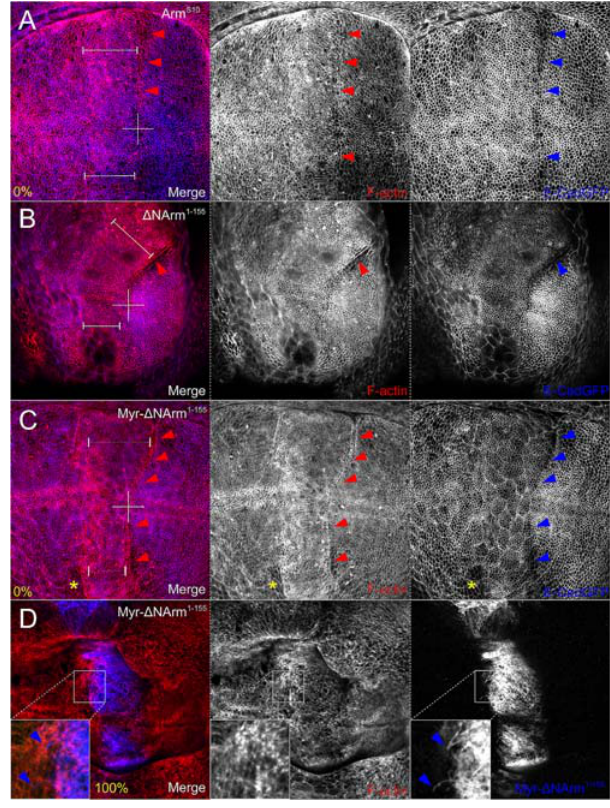
Figure 14. Phalloidin staining reveals a strong F-actin cable at the A/P boundary corresponding with reduced E-Cadherin in D NArm 1–155 and Myr- D NArm 1–155 , but not in Arm S10 . The extent of the overexpression domain is indicated with dimension lines, as assessed by staining (not shown here). (A) Although F-Actin staining clearly indicates the aligned cells at the A/P boundary with Arm S10 , no change in levels was observed. (B) In contrast, overexpression of D NArm 1–155 results in stretching of the A/P cells and an increase of F- Actin (red arrowhead), corresponding to a region of low E-Cadherin expression (blue arrowhead). Note the folding of the epithelium which reveals peripodial membrane cells. (C) Similarly, Myr- D NArm 1–155 causes stretching and F-Actin accumulation at the A/P boundary where E- Cadherin is lower (red and blue arrowheads), and even appears to induce boundary cell-like behaviour at the anterior extent of mutant overexpression (yellow asterisk). (D) Basally, Myr- D NArm 1–155 uniquely causes the formation of filopodia, the base of which are associated with F-Actin bundles (inset).